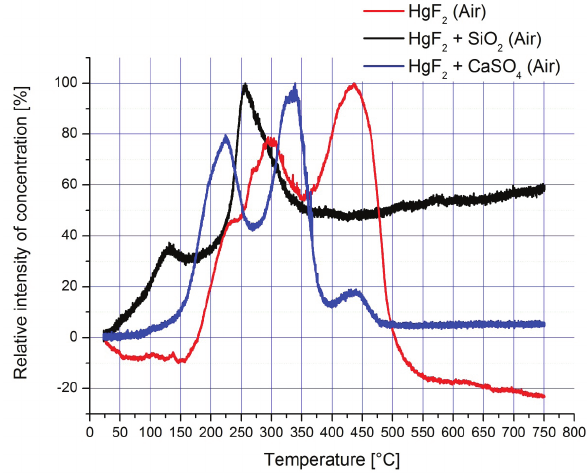
, purged with nitrogen. 2